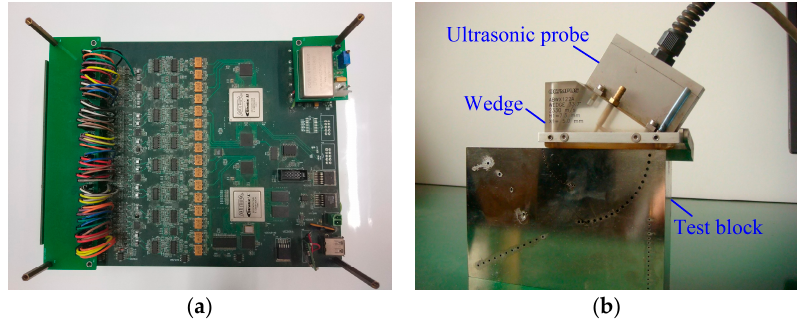
Figure 11. The ultrasonic phased array detection system. ( a ) Circuit board of ultrasonic transmitting and defect echo receiving; ( b ) Ultrasonic probe and standard test block.